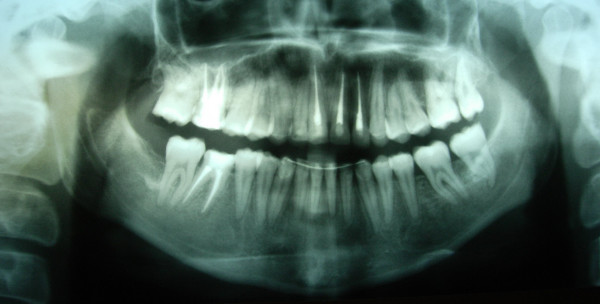
Final OPG of case 1.